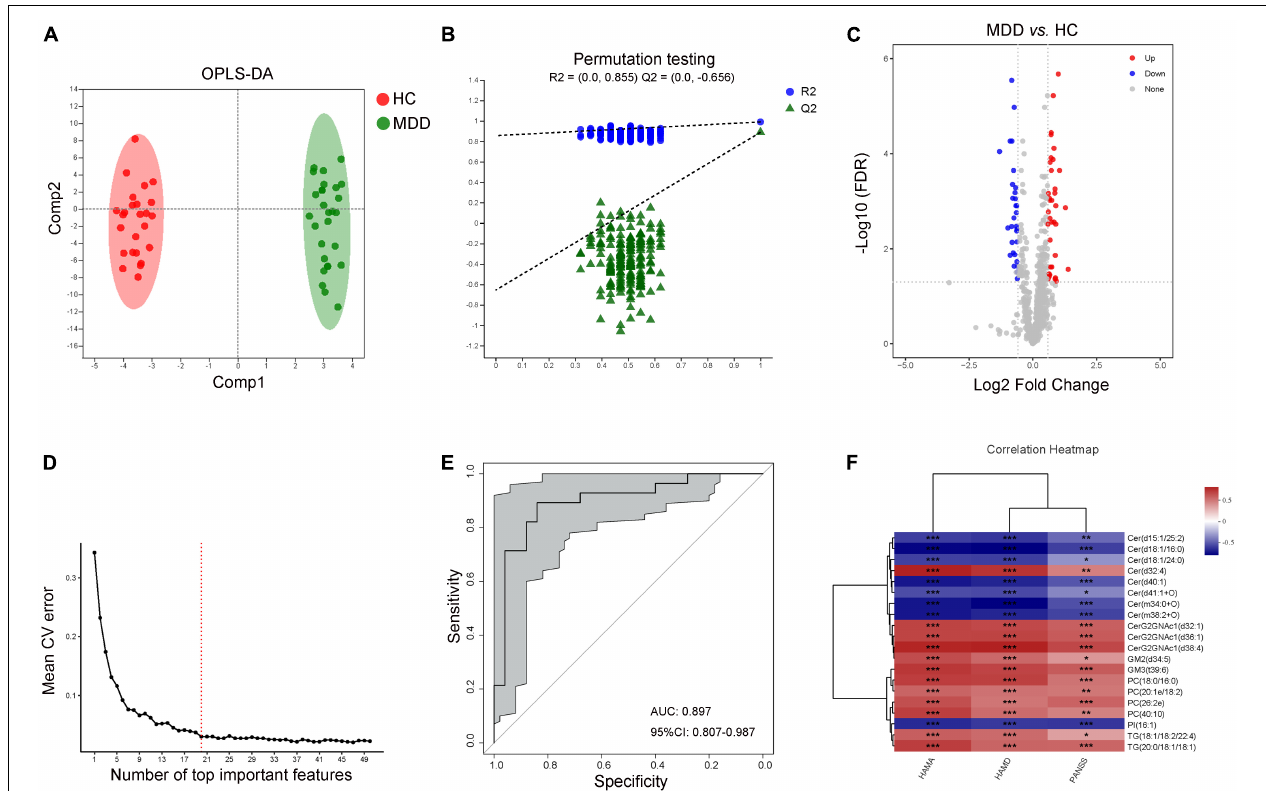
FIGURE 3 | Characteristic lipid species in MDD. (A) Scatter plot of OPLS-DA model and (B) validation model of permutation test, (C) volcano map reveals the increased (red dots) and decreased (blue dots) lipid species between the MDD and HC, (D) random forest model and 10-fold cross-validation showed that the lipids with the top 20 importance had the lowest model error rate, (E) ROC analysis for the combinational lipids, (F) correlation between clinical parameters and levels of 20 lipid species. * P < 0.05; ** P < 0.01, *** P < 0.001.